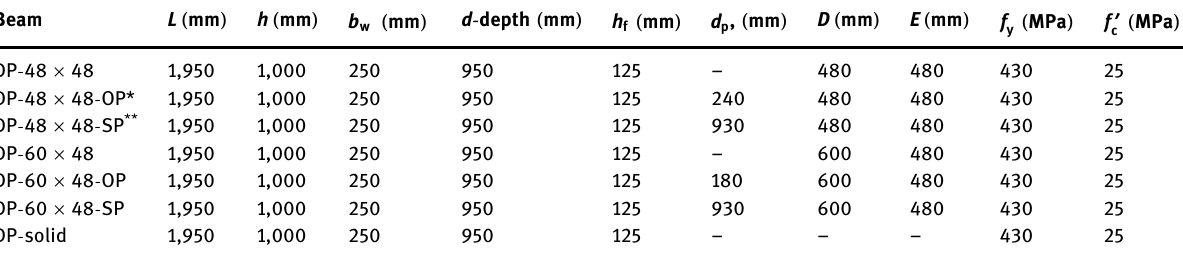
Table 1: Dimensions of full - scale post - tensioned and ordinary deep beams Beam